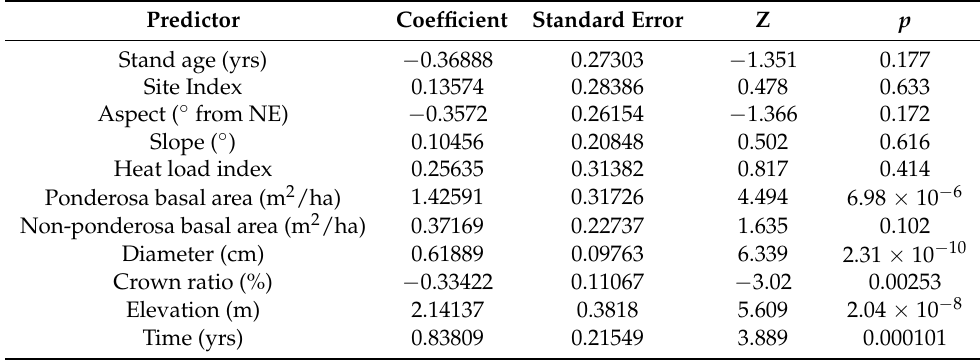
Table A1. Outputs from the Objective 1 model containing all stand- and tree-level variables. Predic- tors have been mean-centered and scaled by their standard deviation.